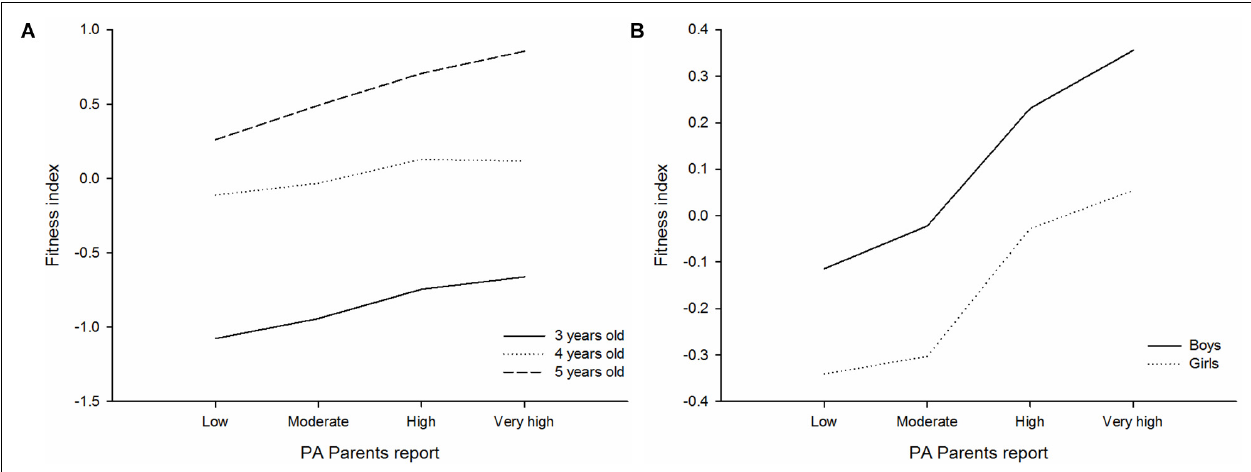
FIGURE 2 | Differences of physical fitness index across parent-reported physical activity levels, by age (A) and gender (B) in preschool children ( n = 3.179). SRT, shuttle run test; PA, physical activity. The analyses were adjusted by age, sex, and maternal